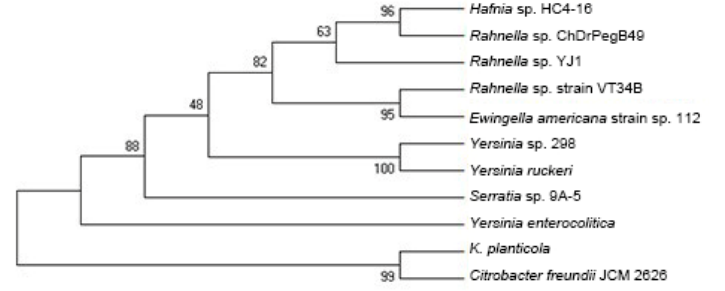
Figure 1. Phylogenetic tree of Strain 298 and related species. The 16S rDNA sequences were used for this analysis. The numbers (0~100) on the branches indicated the reliability of the branch. A larger value means the branch is more reliable.